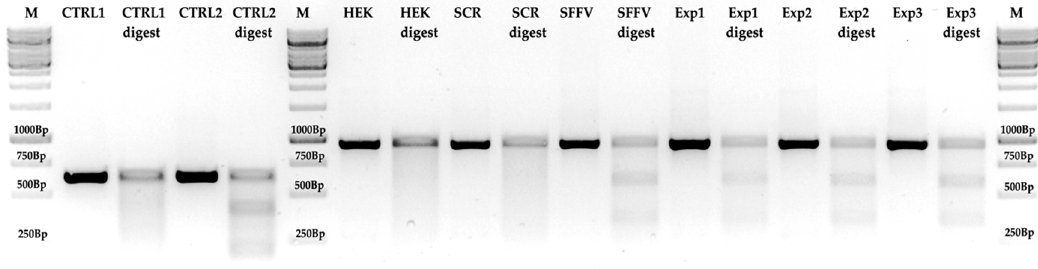
Figure 6. Surveyor nuclease assay of synNotch-mediated gene editing: Control homoduplex DNAs (CRTL1) did not give rise to additional bands after digestion (CTRL1 digest). Control heteroduplex DNA (CTRL2) showed the expected bands. Homoduplex HEK CXCR4 DNA (HEK) and heteroduplex CXCR4 DNA from receiver cells harboring scrambled guide RNA (SCR) did not show extra bands after nuclease treatment (HEK digest, SCR digest). Heteroduplex CXCR4 DNA from receiver cells harboring either the constitutively expressed Cas9 (spleen focus-forming virus (SFFV)) or the tTA-inducible CMV min (experiments 1–3) showed the same band pattern after nuclease treatment (SFFV digest; experiments 1–3 digest). A 1 kbp ladder was used for size control on 1.5% analytic agarose gel.